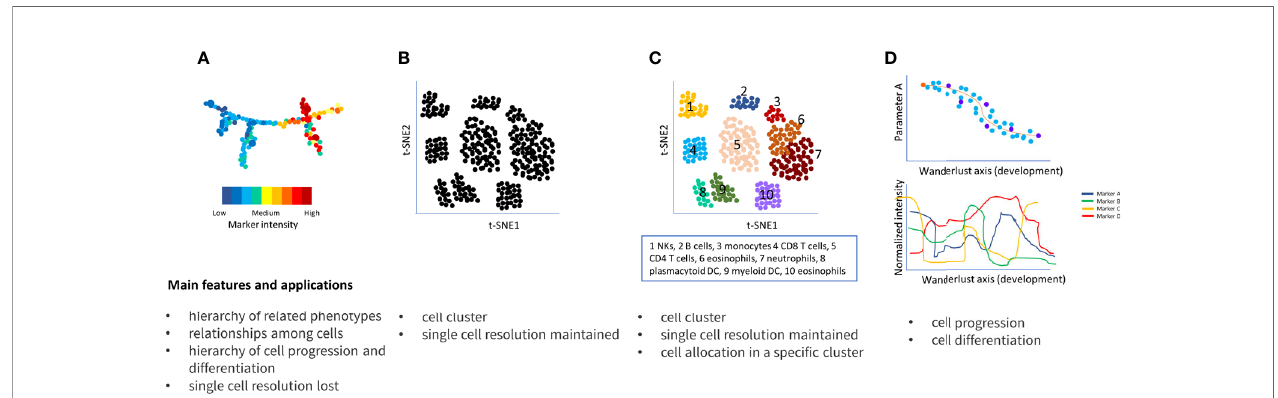
FIGURE 4 | Main approaches to resolve fl ow cytometry data complexity. (A) SPADE connects clusters of multidimensional data in a progressive dendrogram. Cluster sizes correlate with the number of cells within the cluster. The heat map indicates the intensity of each cluster based on the median intensities of a protein marker in each cell node; (B) t-SNE detects cluster corresponding to cell population, similar cell are placed close together re fl ecting their proximity in high- dimensional space; (C) vi-SNE, ACCENSE, DensVM and Phenograph are evolution of t-SNE and similarly visualized; in particular, Phenograph is able to assign each cell into a speci fi c cluster; (D) Wanderlust orders cells into a trajectory corresponding to their developmental